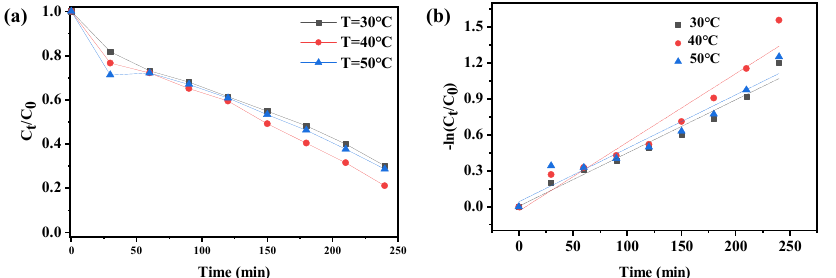
Figure 8. ( a ) Degradation rate of compound 1 to ciprofloxacin under different temperatures, ( b ) Quasi − first order kinetic reaction rate at different temperatures.